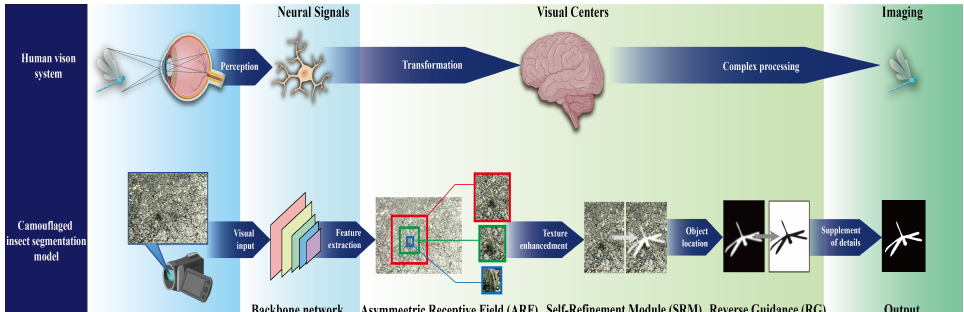
Figure 4. The process of PRNet for camouflaged insects, i.e., PRNet, consistent with the process of human